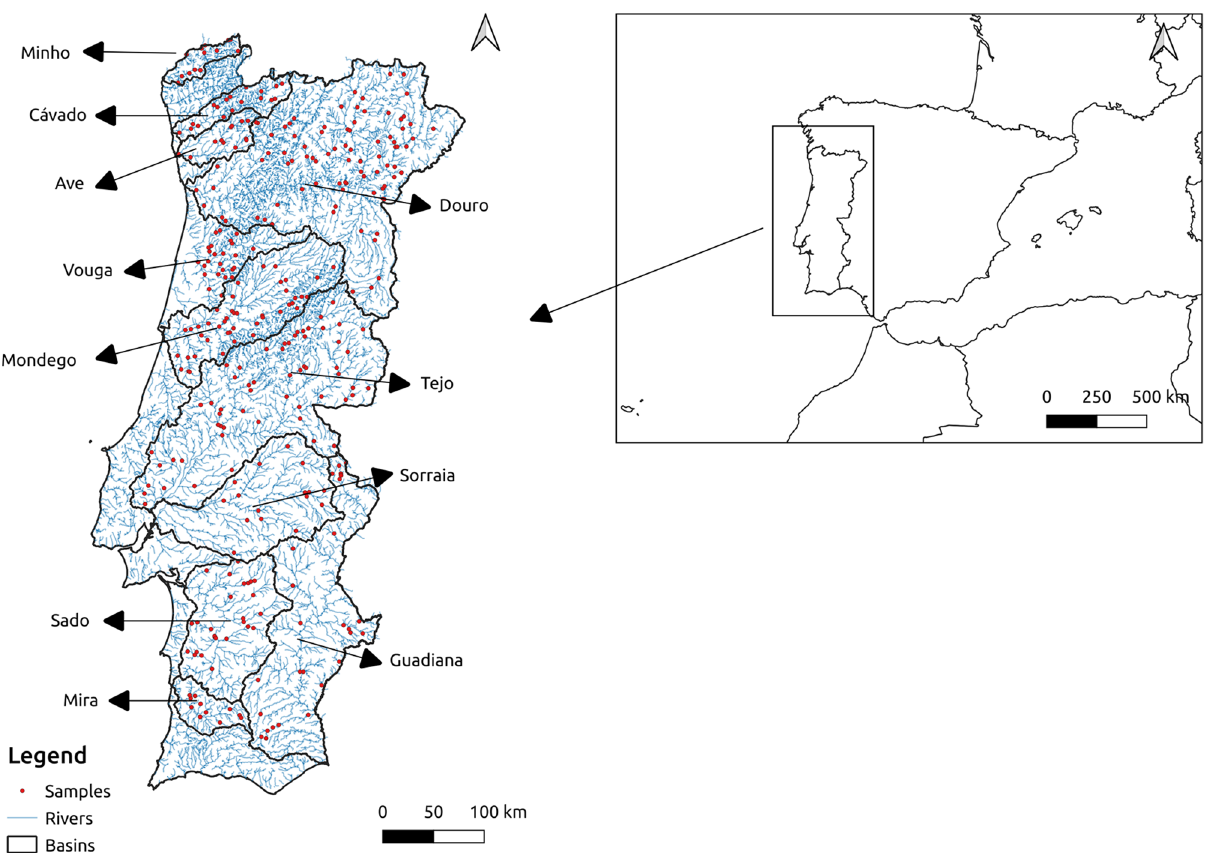
Figure 1. Continental Portugal and the location of the vegetation plots in the eleven river basins studied (red dots). This figure was created with QGIS 3.20.3 63